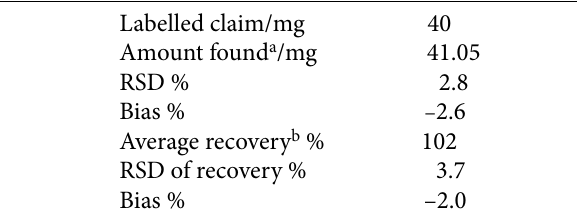
Table 2. Pantoprazole content and mean recoveries in tablet dosage form (Protonex® tablets) obtained by SW-AdSV Labelled claim/mg